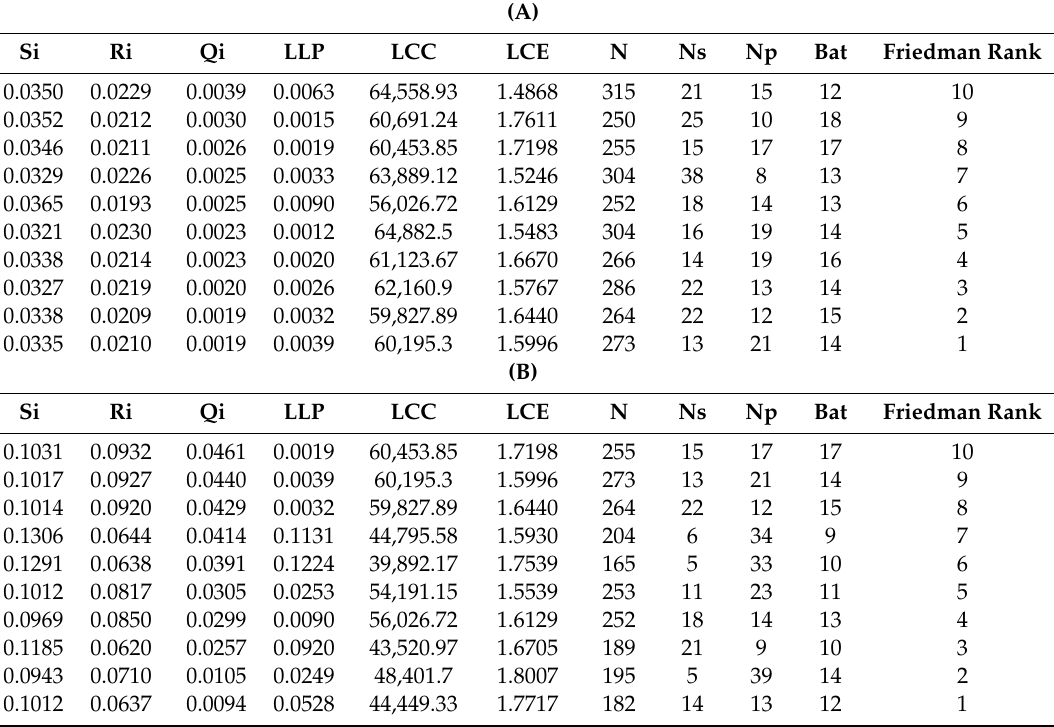
Table 9. ( A ) Results of the AHP-VIKOR method of the SAPV system based on the AGM battery for the first evaluator. ( B ) Results of the AHP-VIKOR method of the SAPV system based on the AGM battery for the second evaluator. ( C ) Results of the AHP-VIKOR method of the SAPV system based on AGM battery for the third